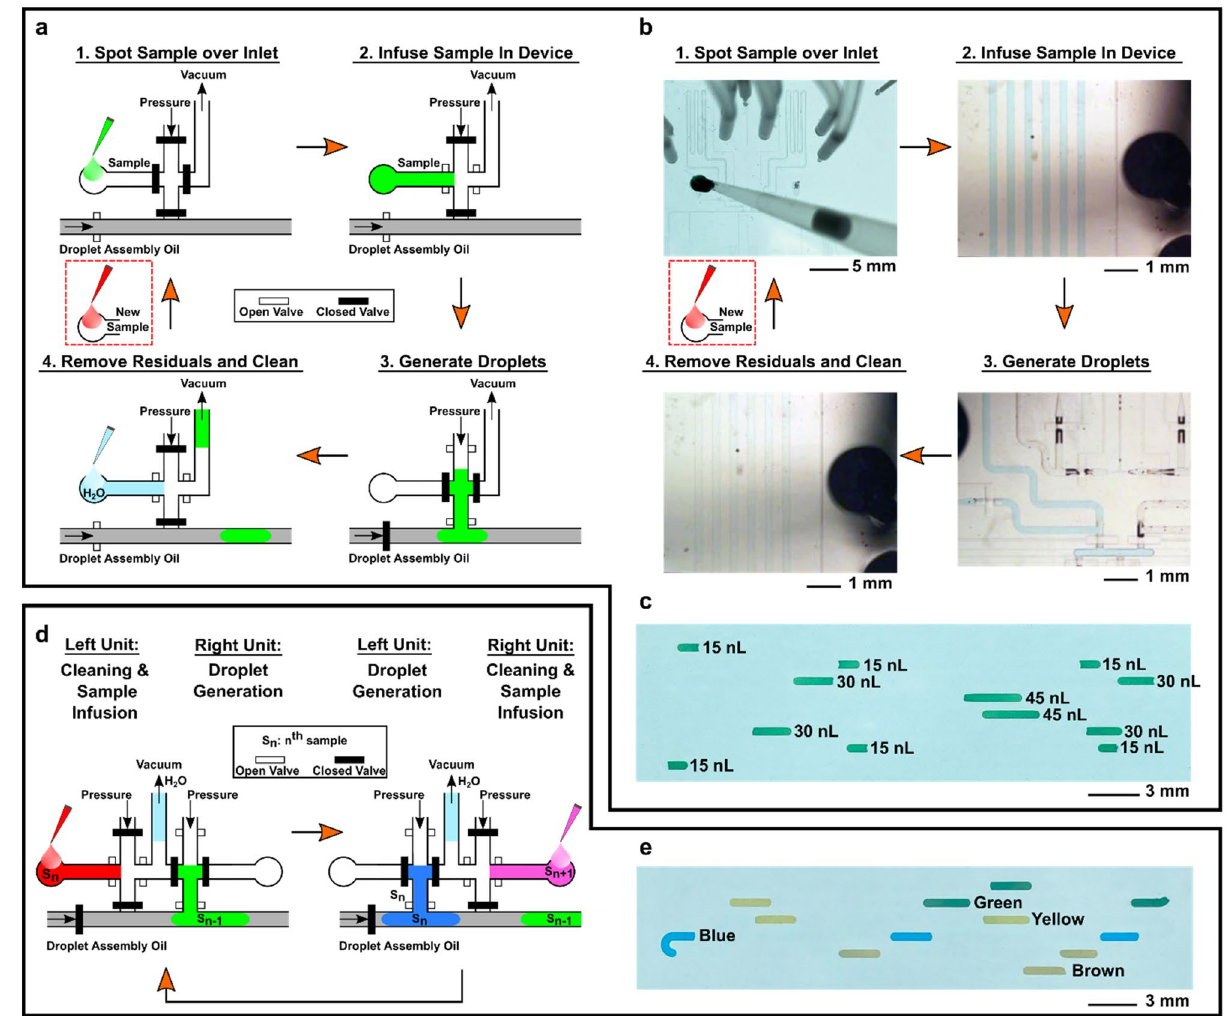
Figure 3. Operation of TESLI. ( a ) TESLI operates in a 4-step cycle (shown here in a schematic): 1. Spotting sample over inlet, 2. Infusing sample in device, 3. Generate droplets, and 4. Removing residuals and cleaning. ( b ) The 4-step operation is demonstrated in an integrated droplet device using blue food dye as the sample via photography (step 1) and bright-field microscopy (steps 2–4), which focuses around either the sample storage channel (steps 2 and 4) or the droplet assembly channel (step 3). ( c ) Using green food dye as the sample, programmable droplet generation upon sample loading using TESLI is demonstrated through a series of droplets with the programed order of 3–15 nL droplets, 2–30 nL droplets, 1–45 nL droplet followed by the reversed order of 1–45 nL droplet, 2–30 nL droplets, and 3–15 nL droplets. ( d ) When two TESLIs are paired to alternate droplet generation with sample infusion and cleaning, samples can be processed at scale without adding idle time. ( e ) As demonstration, brown, blue, yellow, and green food dyes are infused by the dual TESLIs into the integrated droplet device, where each dye is used to generate 3–30 nL droplets, which maintain the same order as sample infusion in the incubation channel. Moreover, uniform spacing between droplets generated from different dyes under fixed microvalve opening times indicates that the samples are infused, and the droplets are generated without idle and measuring the fluorescence intensity throughout the cleaning protocol (Fig. S2). Thus, effective cleaning corresponds to the fluorescence intensity returning to the baseline. Upon initiating all 3 cleaning protocols, we observed immediate decreases of the fluorescence intensities that all gradually approached the baseline, indicat- ing effective cleaning (Fig. 4a–c). However, to minimize cross-contamination, it was necessary to compare min- ute increases in fluorescence intensity (Fig. 4a–c, zoom-in figure). The fluorescence intensities from the last two cleaning protocols returned to the baseline intensity whereas the fluorescence intensity from the first cleaning protocol remained above the baseline intensity, which suggests uncleaned FAM residue remaining in the sample storage channel. Between the last two cleaning protocols with comparably effective cleaning, we selected the sec- ond cleaning protocol (i.e., air evacuation followed by continuous DI water wash) for the remainder of this work because this protocol required spotting DI water only once rather than 8 times as in the cyclic cleaning protocol.